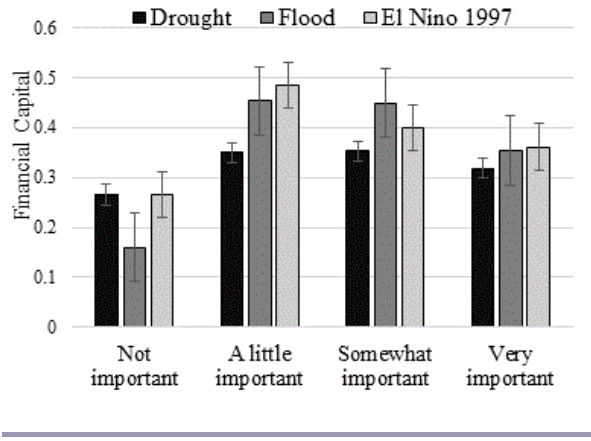
Fig. 6. Financial capital based on rankings by survey households of the importance of trees during drought, flood, and the 1997 El